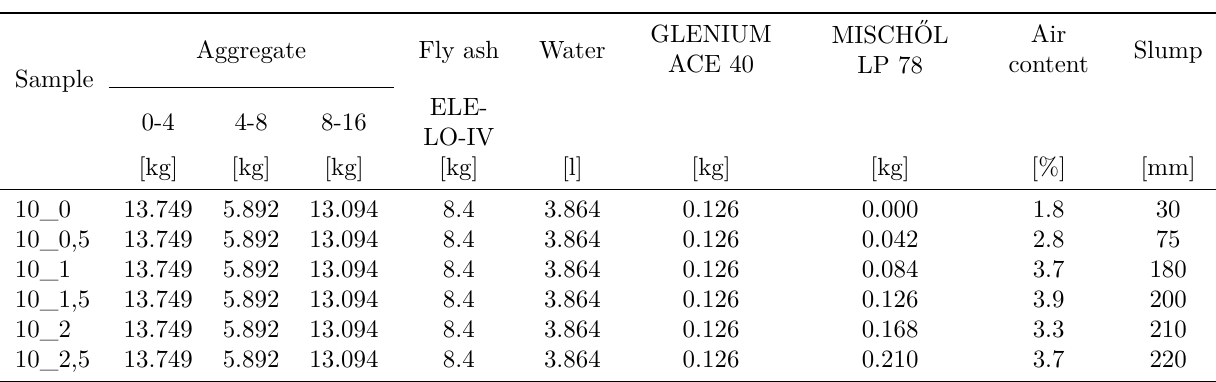
Table 7. Composition of mixtures of the Series no. 10.